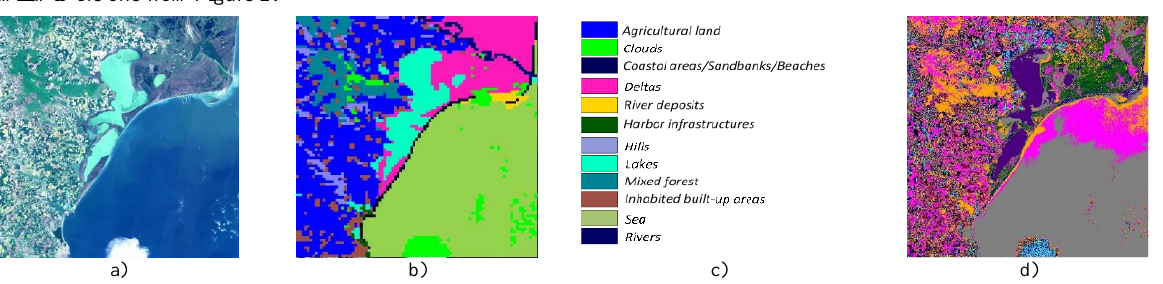
Figure 4 . An image example of the Danube Delta, Romania acquired on April 28 th, 2016. a) The Sentinel-2 RGB (B4, B3, and B2) quick-look image, b) Our semantic classification based on active learning (with Gabor filtering as feature vector applied to each band and an SVM as classifier), and d) Our topic representation based on LDA. The active learning process is supported by a colour legend shown in c); the colour legend of LDA is similar to the one from Figure 2.